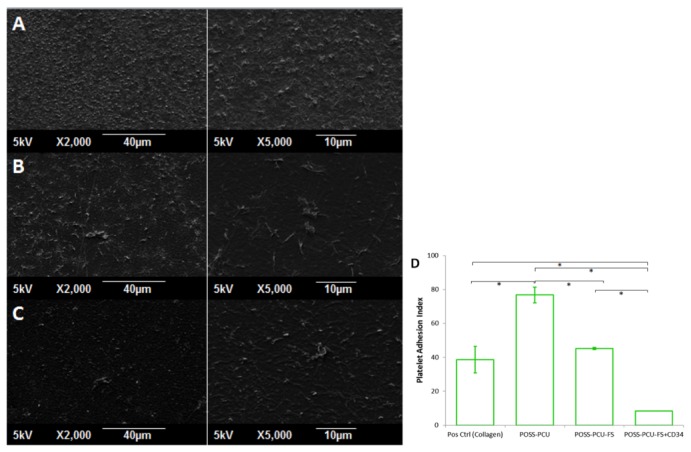
Platelet adhesion assay.(A-C) SEM images (2000x and 5000x magnification) show the greatest number of platelets adhering to POSS-PCU surfaces. (A) POSS-PCU, (B) POSS-PCU-FS, (C) POSS-PCU-FS+CD34. (D) The degree of platelet adhesion, expressed as the Platelet Adhesion Index, was significantly reduced by incorporation of FS and subsequent conjugation of anti-CD34 antibodies. *denotes a significant difference (p < 0.05).POSS-PCU-FS: POSS-PCU with fumed silica anchors, POSS-PCU-FS+CD34: POSS-PCU biofunctionalized with anti-CD34 antibodies.